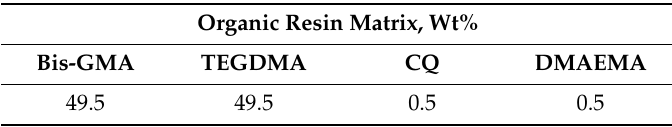
Table 2. The proportion of organic resin matrix. Bis-GMA: bisphenol-A glycidyl methacrylate; TEGDMA: tri-ethylene glycol dimethacrylate; CQ: camphorquinone; DMAEMA: 2-(dimethylamino)